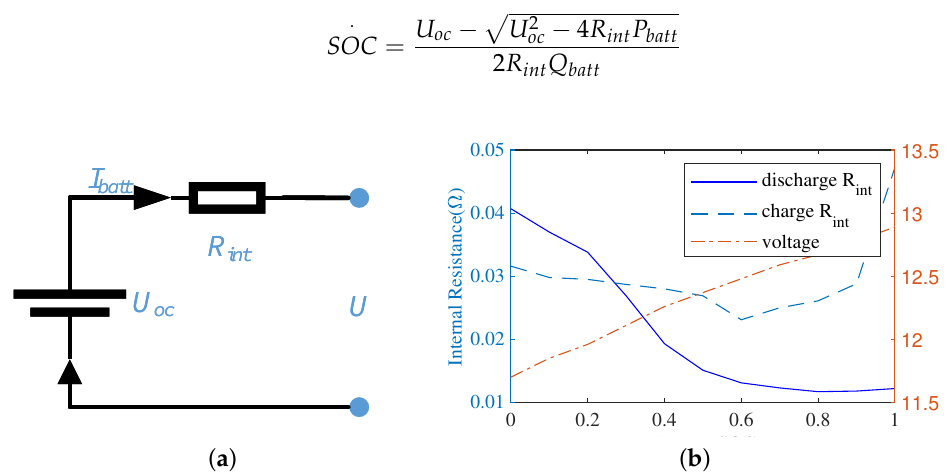
Figure 3. R int model for ( a ) and Internal resistance and open-circuit voltage for ( b